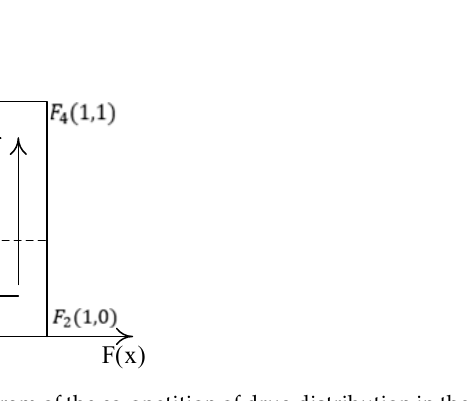
Figure 1. The phase diagram of the co ‐ opetition of drug distribution in the county medical community.